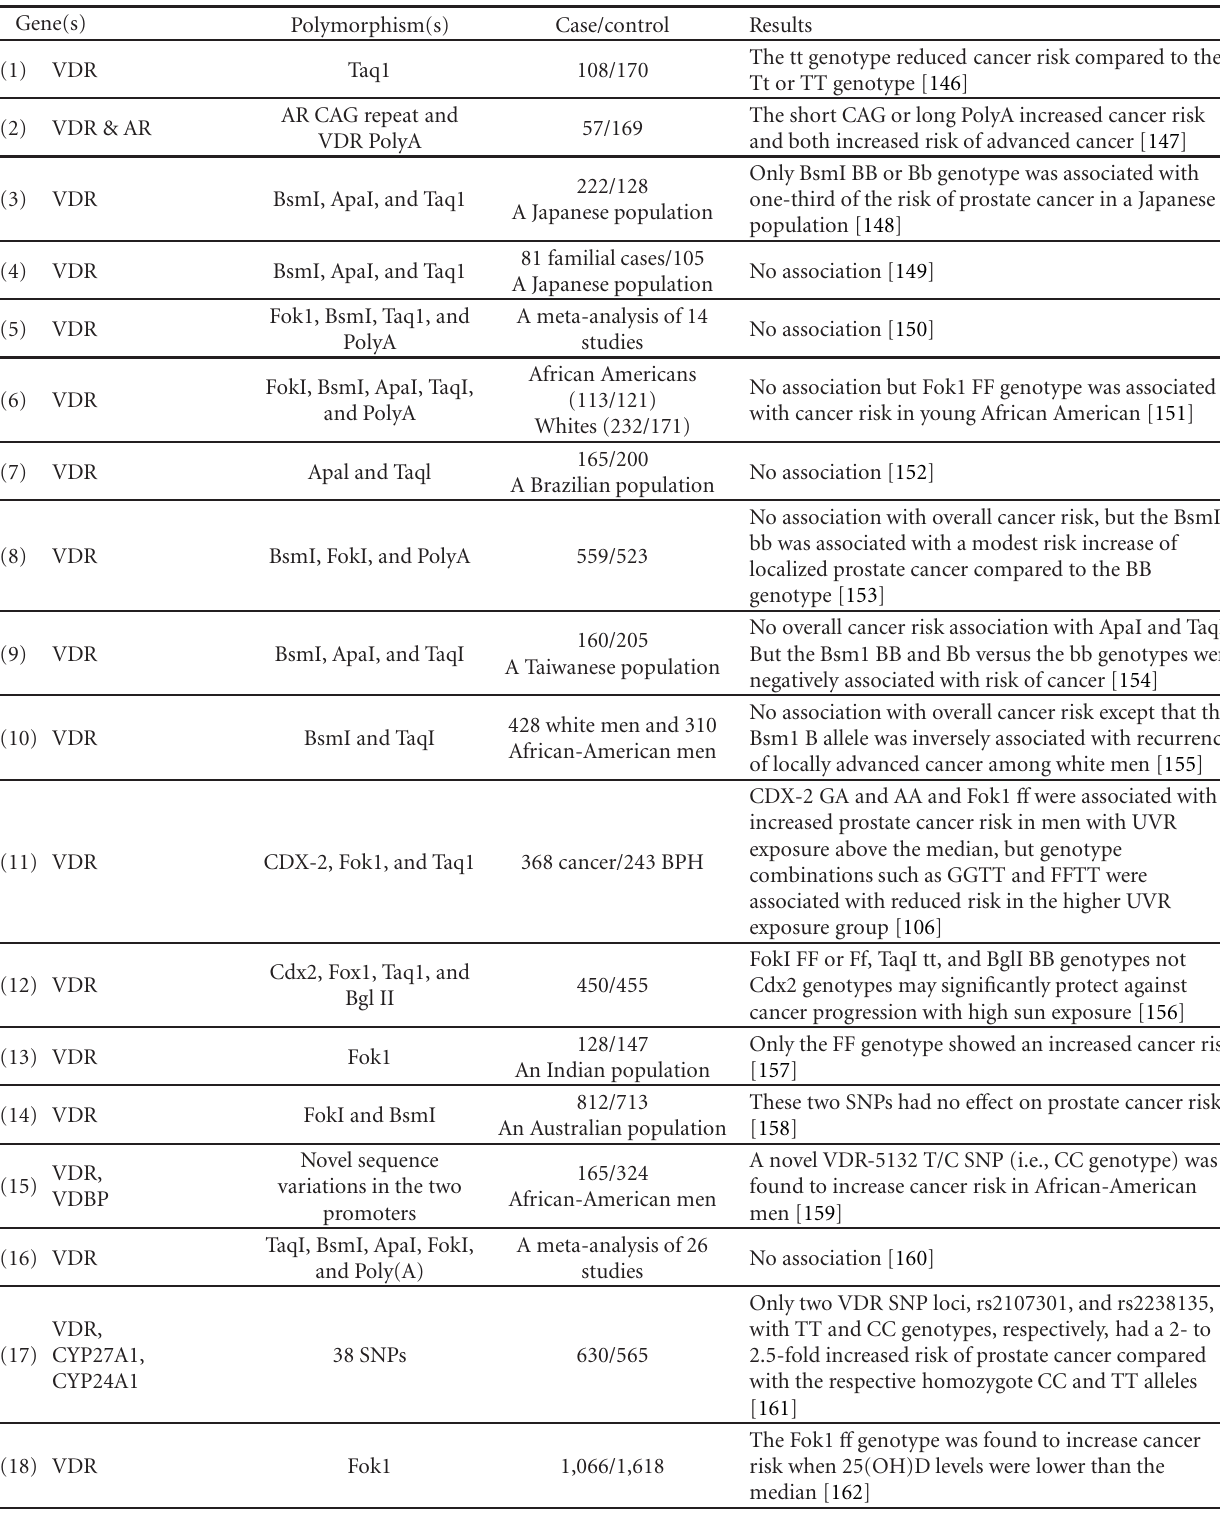
Table 1: Summary of outcomes of 28 studies on the association of analysis of polymorphisms in vitamin D signal related genes with prostate cancer